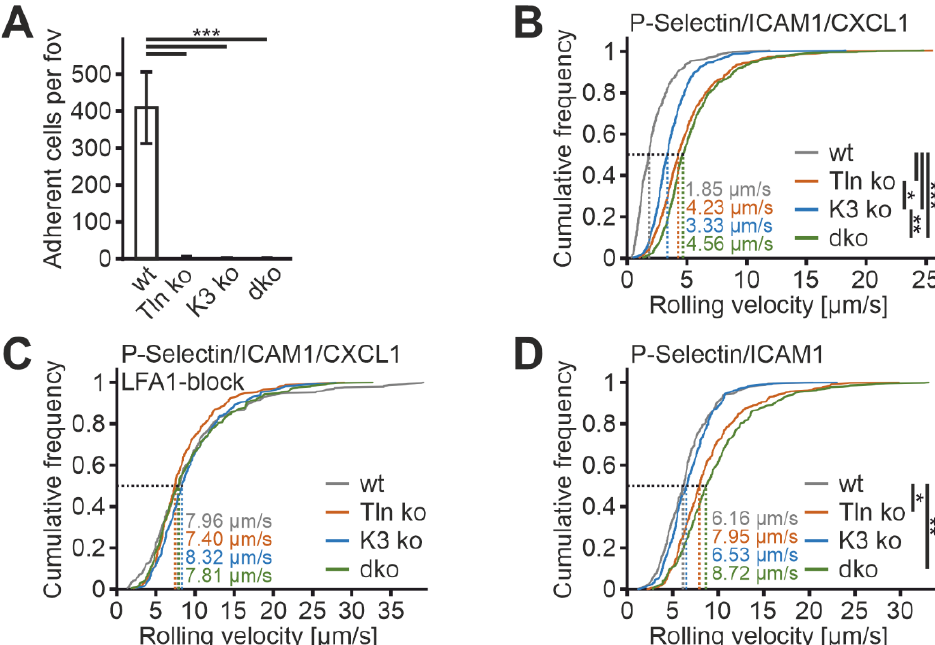
were ablated with the CRISPR/Cas9 system. GAPDH served as loading control. ( C , D ) Relative expressing human integr in β2 and lacking talin1 and/or kindlin3 expression. N = 4 clones. Result of each clone is plotted as individual data point. All values are given as mean ± SD. ** p < 0.01, *** p < 0.001.